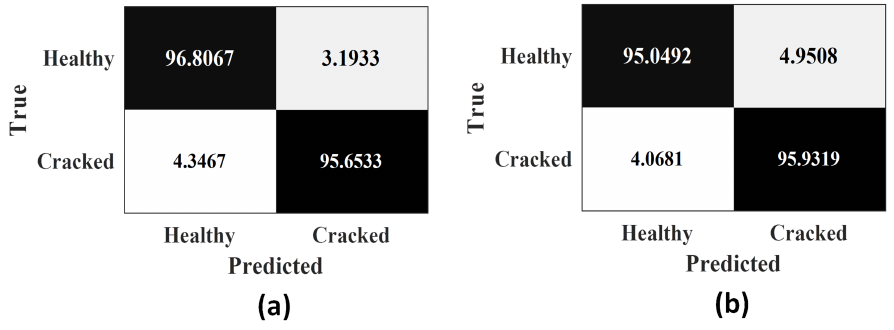
Figure 6. Confusion matrix for the baseline ( a ) U-notch DNN and ( b ) V-notch